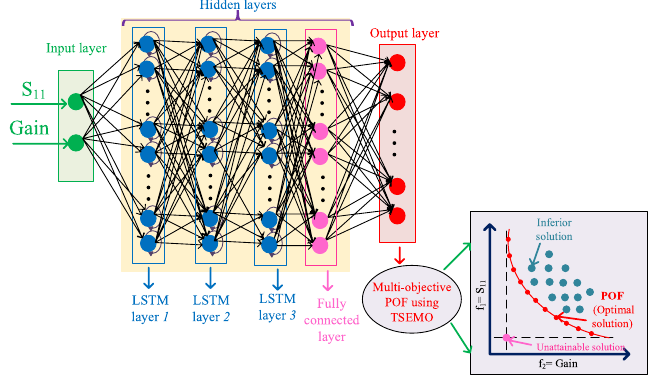
Figure 3. Proposed regression DNN for sizing the antenna shap with